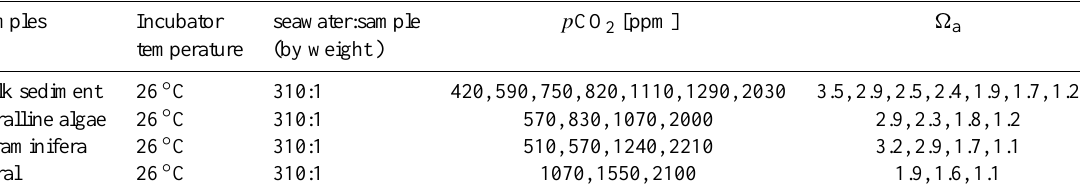
Table 1. Condition for each experiment.